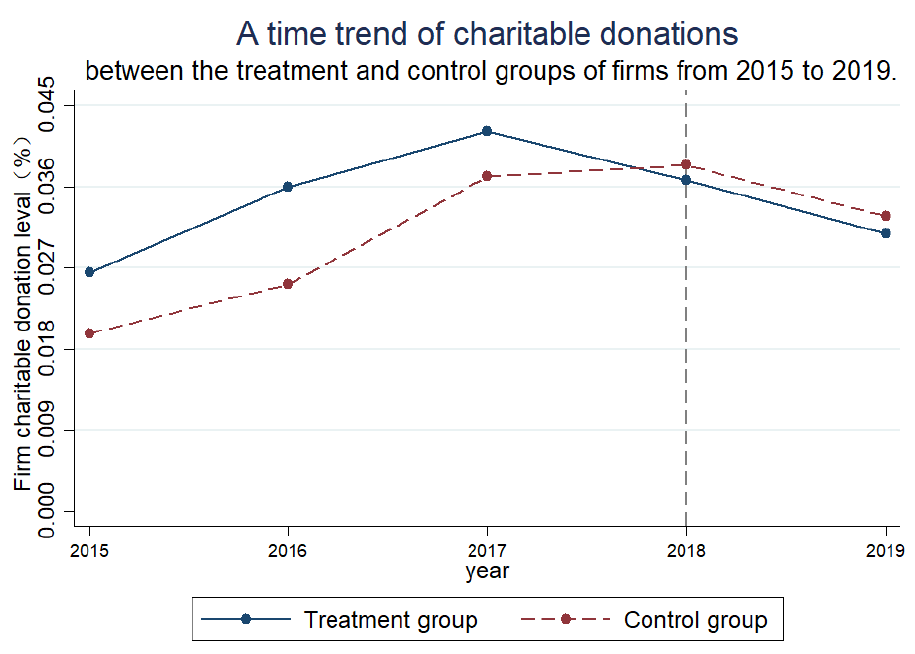
Figure 1. Parallel trend test.